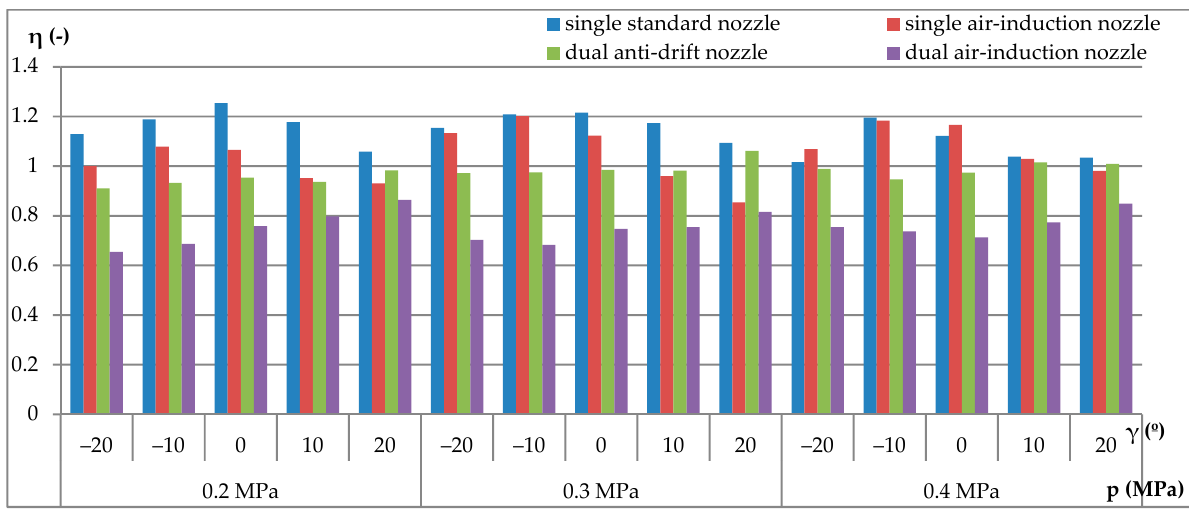
Figure 6. Coverage unevenness coefficient for selected nozzles at 2.2 m ∙ s − 1 driving speed.